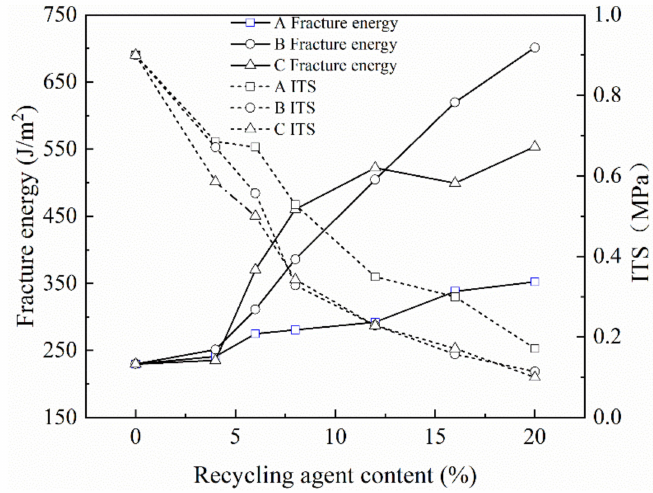
Figure 5. The e ff ect of recycling agent on the fracture energy and ITS of the mixture. (2) SBR